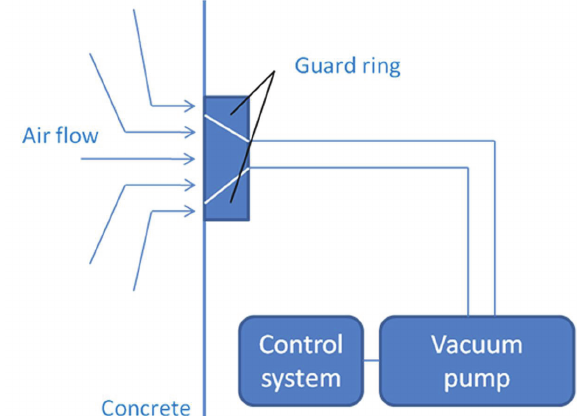
Fig. 2. Schematic of air permeability test